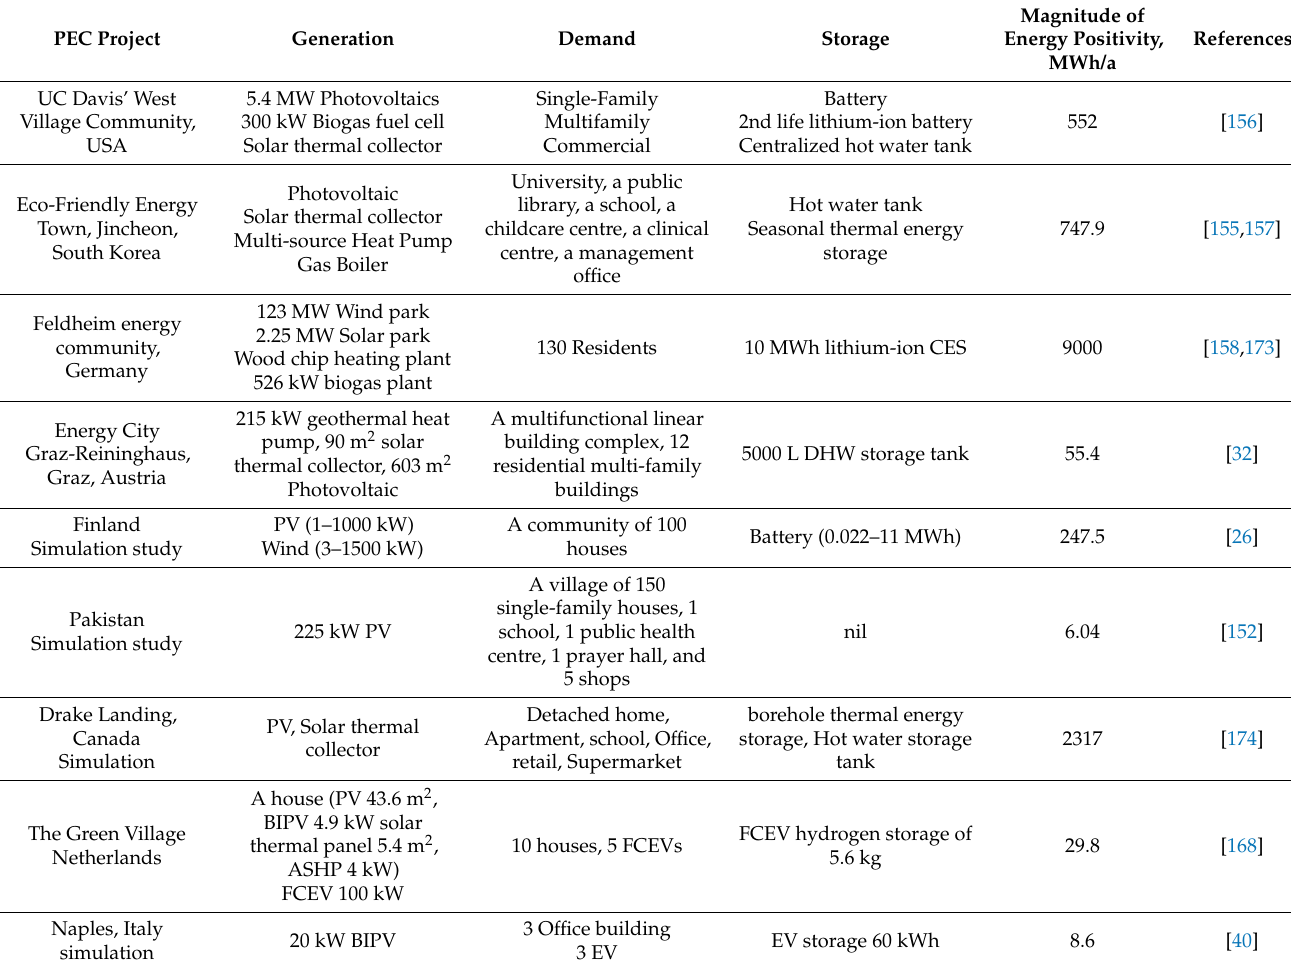
Table 4. Generation, demand, and storage of various PEC